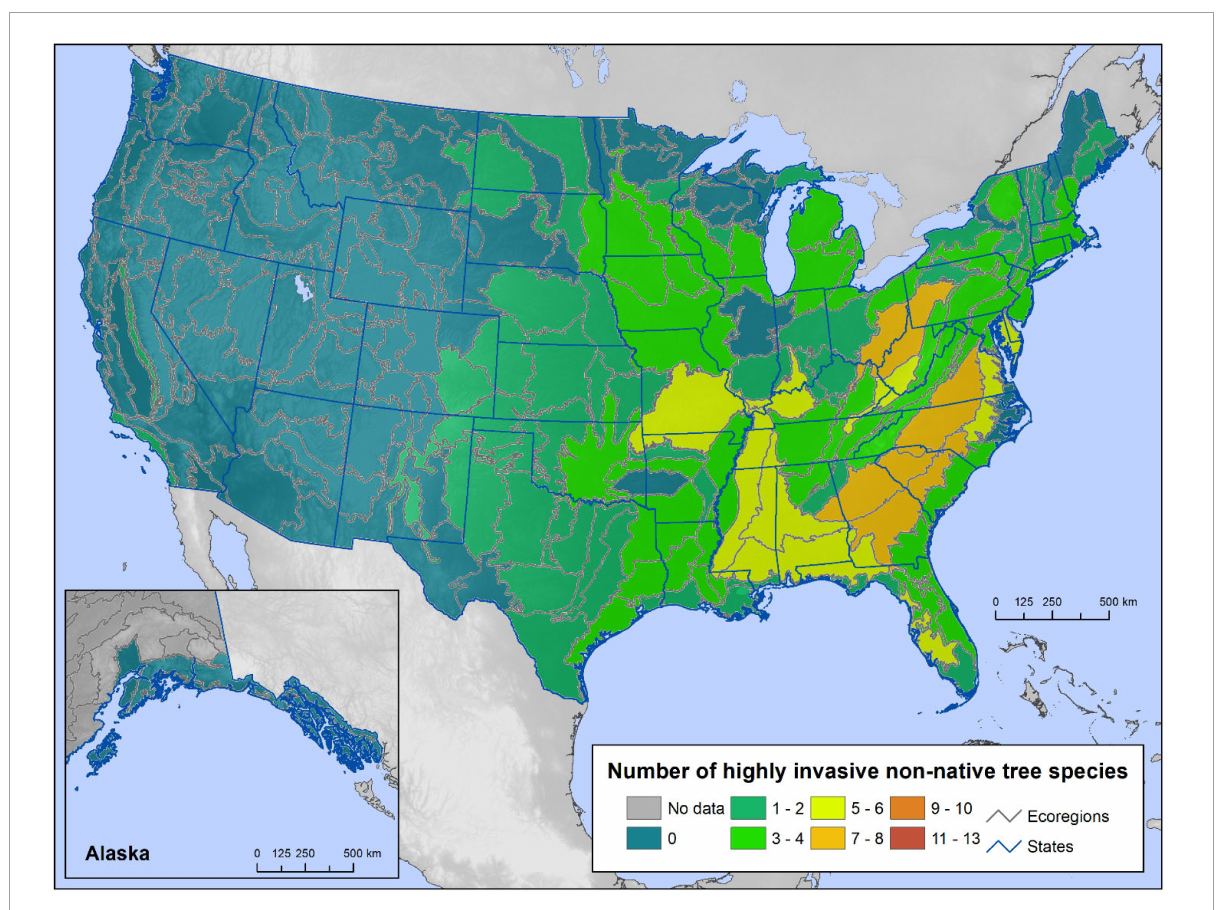
FIGURE3 The number of highly invasive non-native tree species present in each ecoregion section of the conterminous United States and coastal southeastern Alaska using Forest Inventory and Analysis (FIA) tree occurrence data.